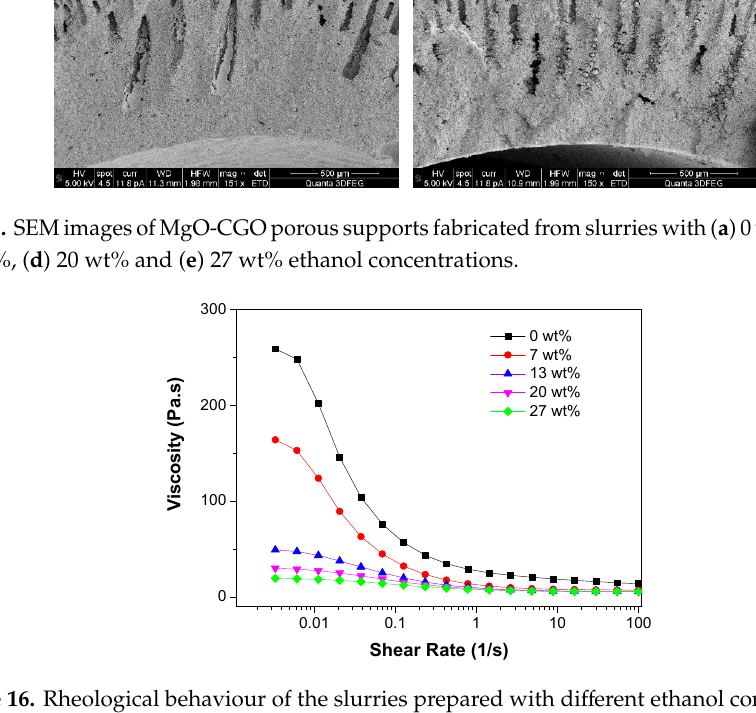
Figure 16. Rheological behaviour of the slurries prepared with different ethanol concentrations.